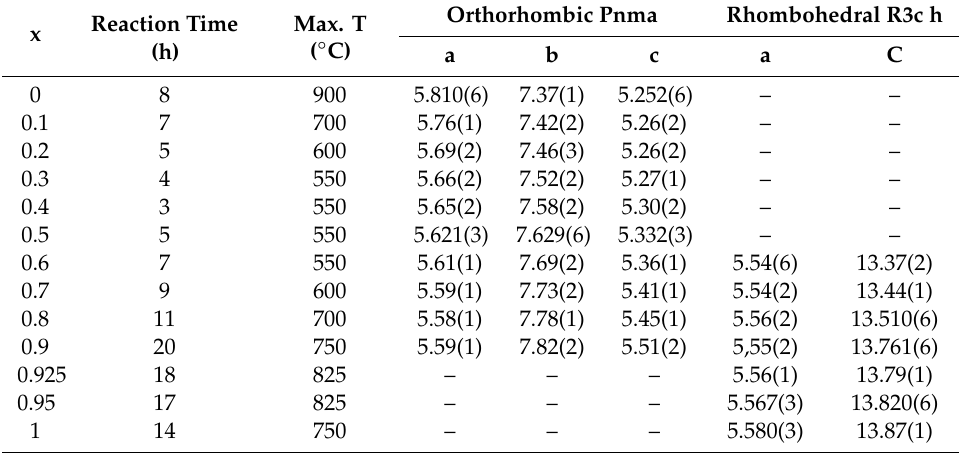
Table 1. Reaction time, maximum temperature before decomposition, and lattice parameters (in